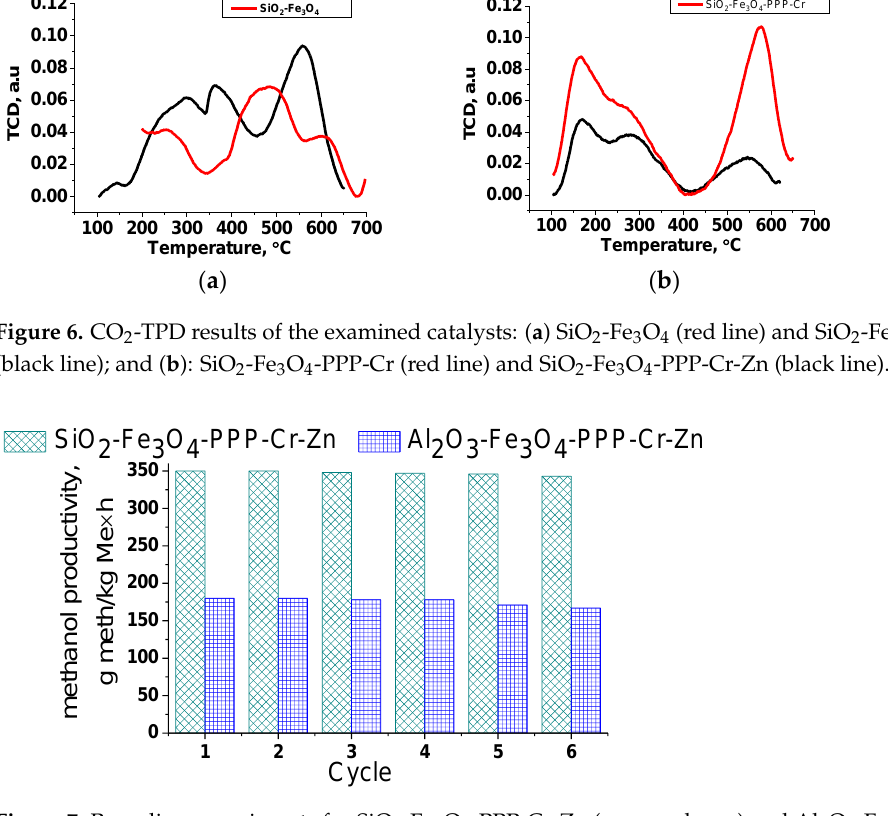
Figure 7. Recycling experiments for SiO 2 -Fe 3 O 4 -PPP-Cr-Zn (green column) and Al 2 O 3 -Fe 3 O 4 -PPP- Cr-Zn (blue column) in CO 2 hydrogenation. Reaction conditions are: 250 °C, 5 MPa, 50 mg of the catalyst, CO 2 :H 2 = 1:4, 15 mL of dodecane, 6h.